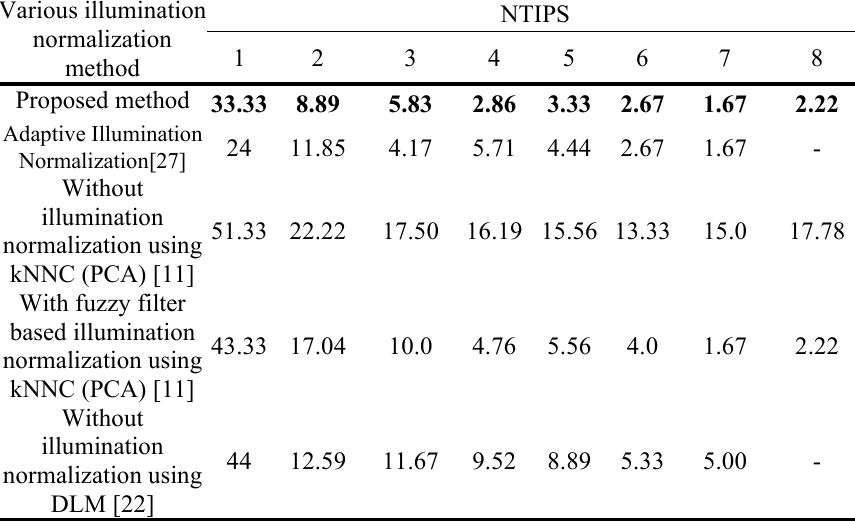
Table 2. Comparison of percentage error rate for NTIPS = 1 to 8 on Yale face database